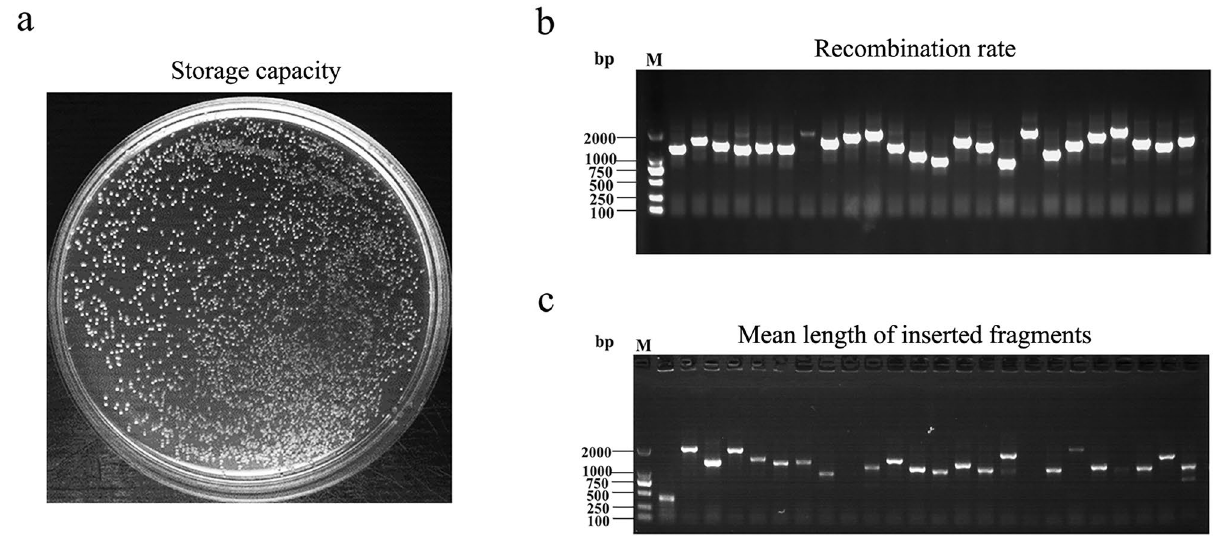
Figure 1. Analysis of the quality of the primary C. chloroleuca 67-1 library. ( a ) Determination of storage capacity. ( b ) Determination of recombination rate using primers pGADT7-F/R. ( c ) Determination of the mean length of inserted fragments from fungal colonies randomly selected by PCR amplification with primers pGADT7-F/R. M DNA 2000 marker, bp base